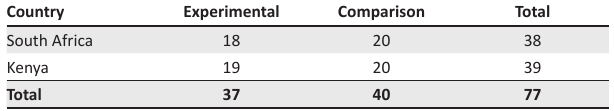
TABLE 1: Number of participants in the South African and Kenyan schools’ experimental and comparison groups.